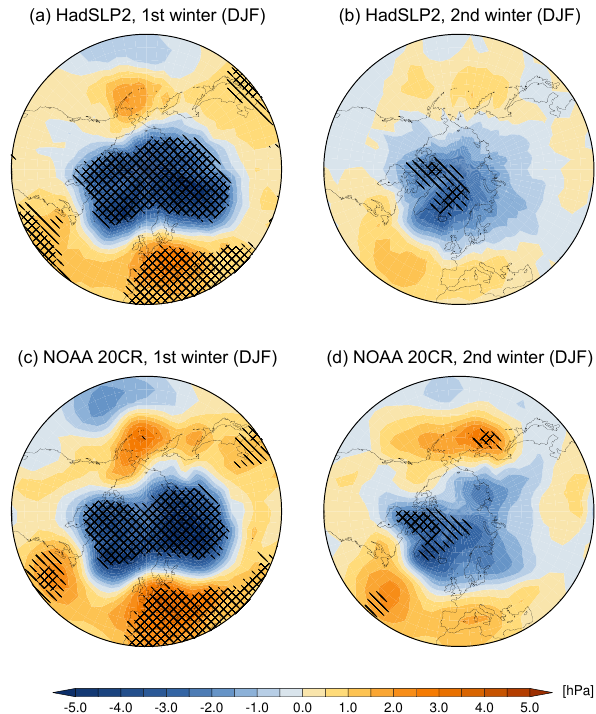
Figure 4. As Fig. 3 but for just NOAA-20CR data and HadSLP2 data, averaged over all five post-volcanic